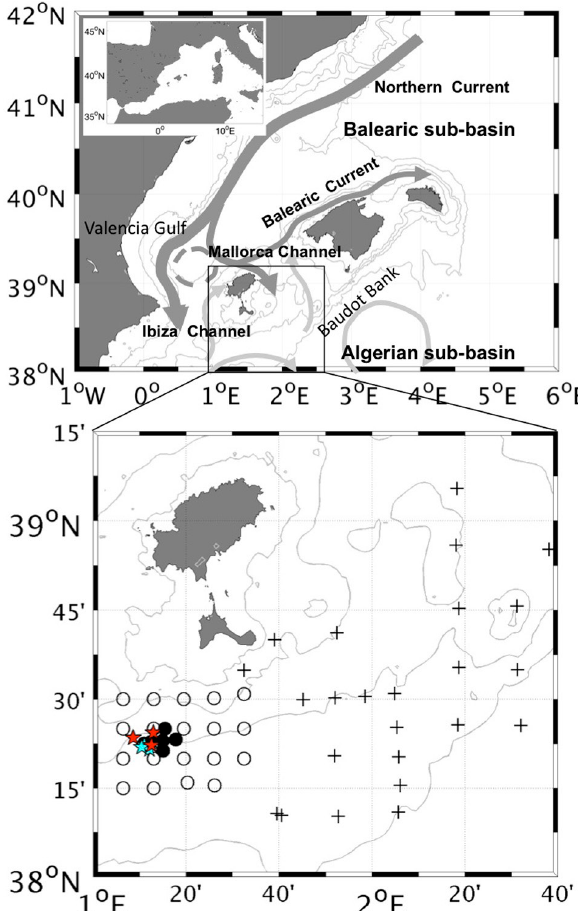
Fig . 1. – Study area and sampling stations. (Top) The Balearic Islands and the main hydrographic features characterizing the re- gional circulation. The Mallorca and Ibiza channels are indicated. The Northern and Balearic currents are shown as dark grey arrows and the Algerian gyres are indicated as light grey arrows. (Bottom) Sampling area with the three blocks of stations designed in the sampling strategy. Circles indicate the first block of stations, stars indicate the second block of stations and crosses the third block of stations (see description in the text). Thin, light grey lines denote isobaths in both figures (100, 500, 1000 and 2000 m). The arrow indicates the location of the